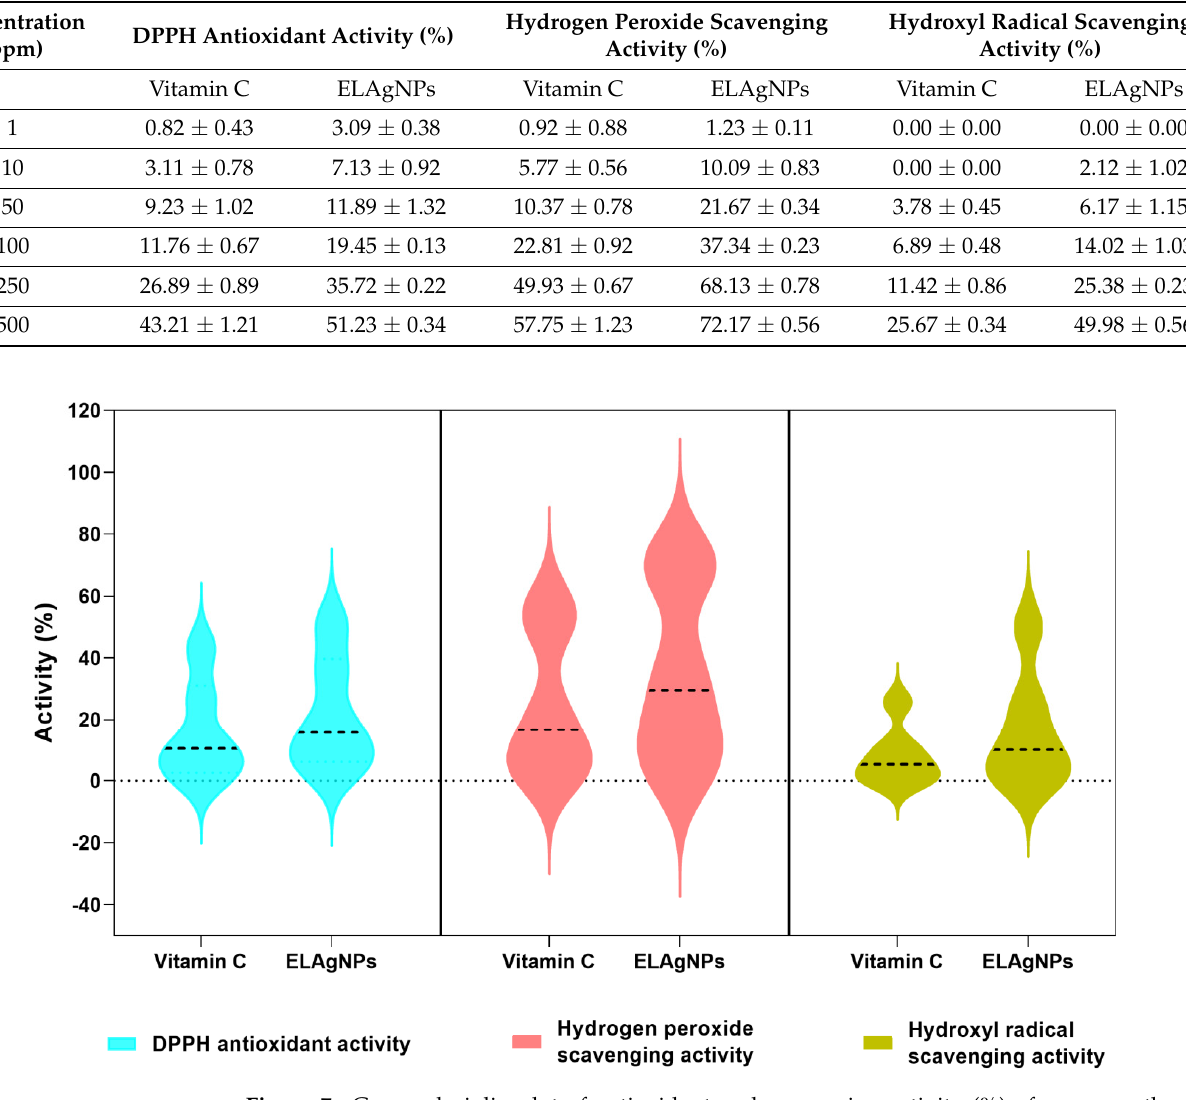
Figure 7. Grouped violin plot of antioxidant and scavenging activity (%) of green synthesized ELAgNPs with standard vitamin C.